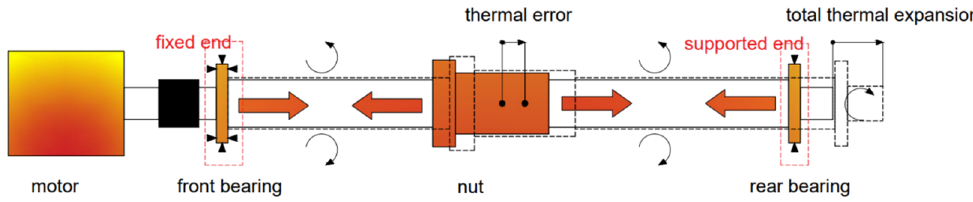
Figure 1. Three-axis drilling machine.